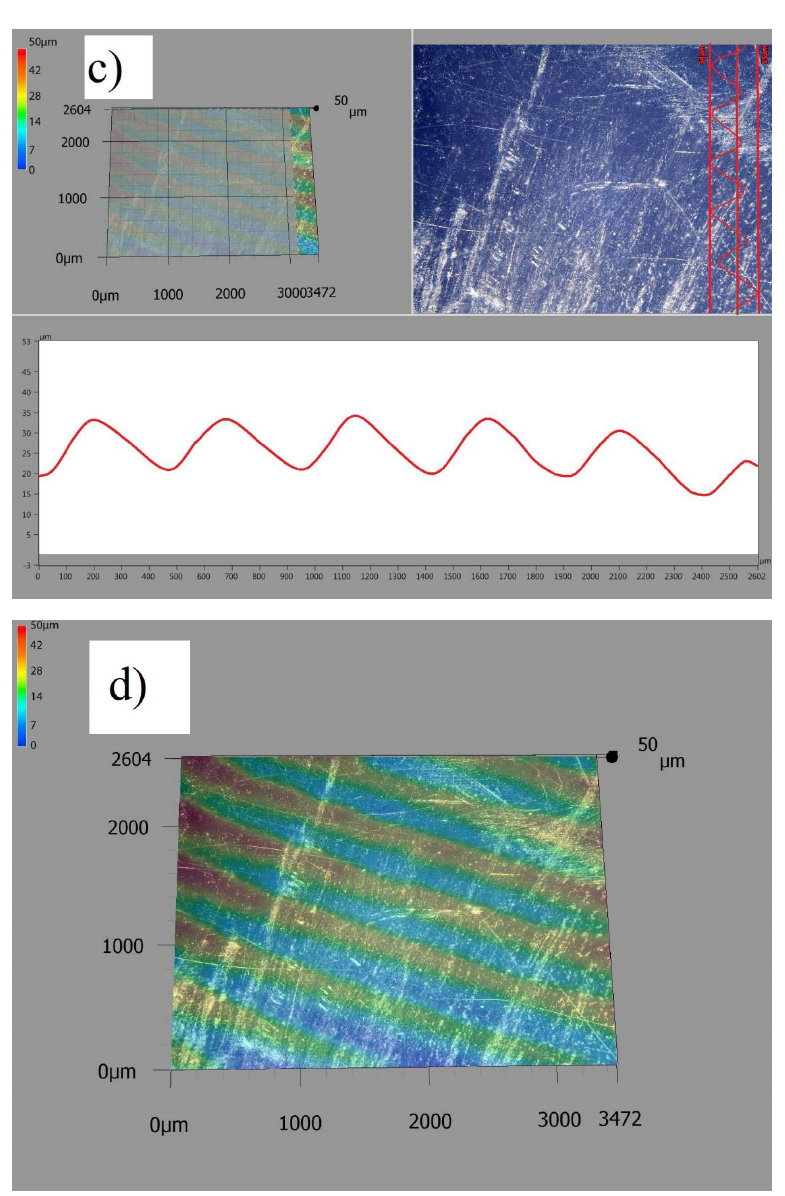
Figure 8. Scratch marks on tibial components after ca. 6 years of use, a ) surface topography at the beginning of wear, b ) surface topography in the middle of wear, c ) surface topography at the end of wear, d ) full surface topography.